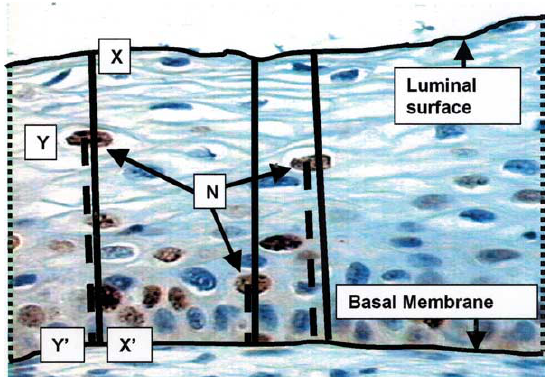
Fig. 1. Illustration of the image analysis method. The microscopic image of the cervical epithelium is shown on the monitor of the im- age analysis system. The operator demarcates with the mouse a diag- nostic epithelium strip, carefully avoiding tangentially cut areas. The demarcation lines are shown as black lines (luminal surface, basal membrane, left, right). Within the demarcated strip, the operator then clicks with the mouse on all Ki67 positive nuclei. After each click, the system automatically draws a perpendicular line from that point to the basal membrane and over the full thickness of the epithelium (these thin dotted lines are barely visible for all nuclei) and calculates several quantitative features such as thickness = T of the epithelium at that point, distance = D of the point to the basal membrane, the stratification index = Si = (D / T) and others. In the figure, points N are marked Ki67 positive nuclei with D = dotted line = Y–Y’ and T = continuous line = X–X’. This procedure is further illus- trated for two other Ki67 positive nuclei. The Si’s are 0.80, 0.19 and 0.67 respectively. This procedure is further illustrated for three Ki67 positive nuclei. The Sis are 0.80, 0.19 and 0.67 respectively.